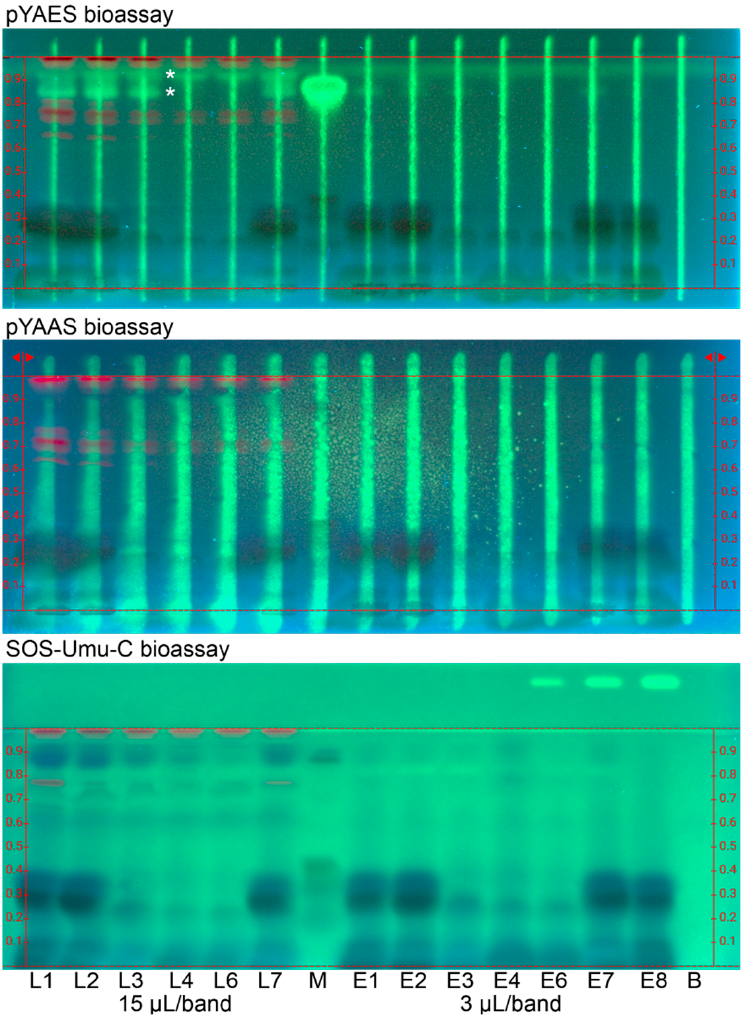
Figure 2. Bioprofiling for endocrine active and genotoxic compounds: HPTLC–FLD bioautograms of peppermint products (Table 1) extracted with water—ethanol—ethyl acetate 1:1:1 (0.1 mg/mL each; 15 µL/band or 1.5 mg for L1–L7, and 3 µL/band or 0.3 mg for E1–E8; L5/E5 skipped) on HPTLC plate silica gel 60 along with standard mixture (M; eriocitrin, luteolin-7- O -glucoside, rosmarinic acid, and apigenin, 2.3 µg/band each) and the respective solvent blank (B) separated with 7 mL ethyl acetate—toluene—methanol—water 4:1:1:0.4 and detected at 254 nm via the duplex